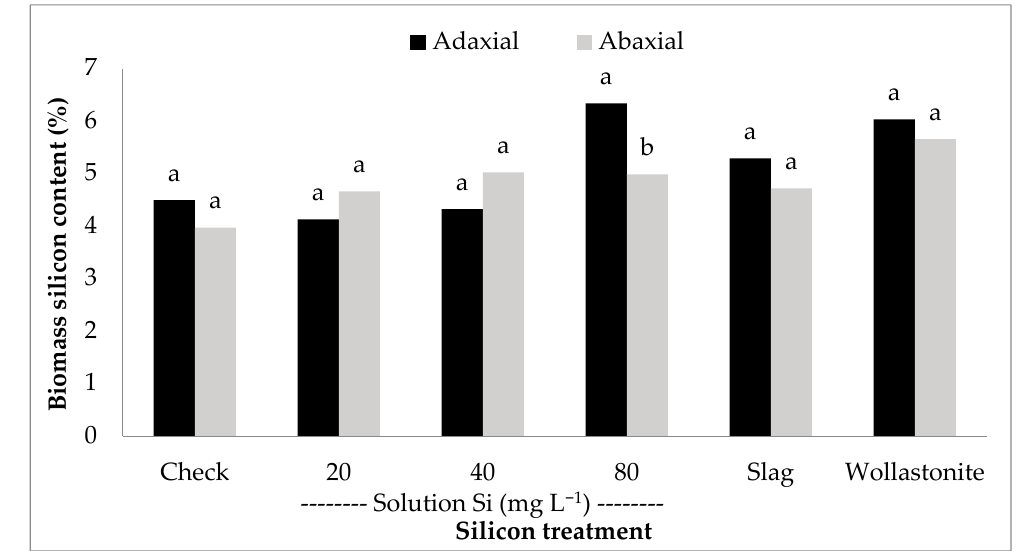
Figure 3. Silicon content of rice adaxial and abaxial leaf surface under scanning electron microscopy (SEM) and EDX with different silicon treatments. Bars labeled with the same letter within Si treatment are not significantly different at P < 0.05 according to Tukey’s test. Silicate slag and wollastonite rates: 690 and 1190 kg Si ha − 1 , respectively.